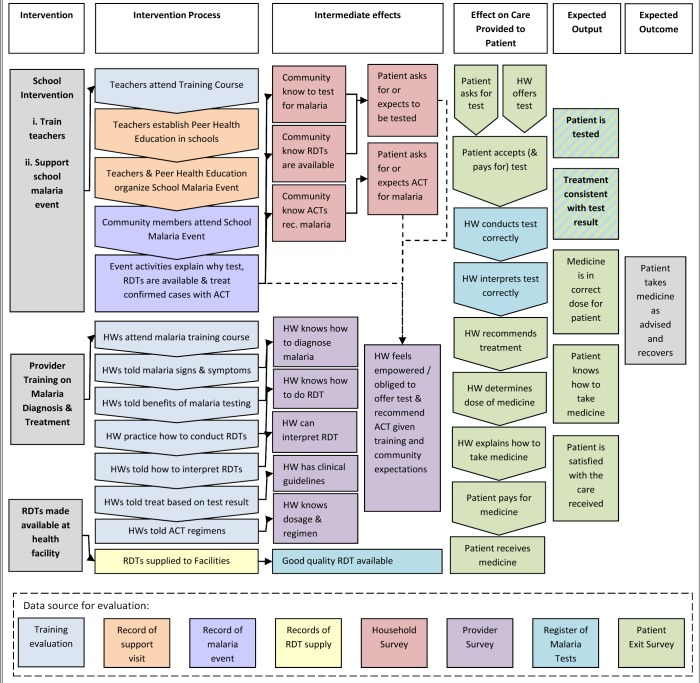
Logical framework.